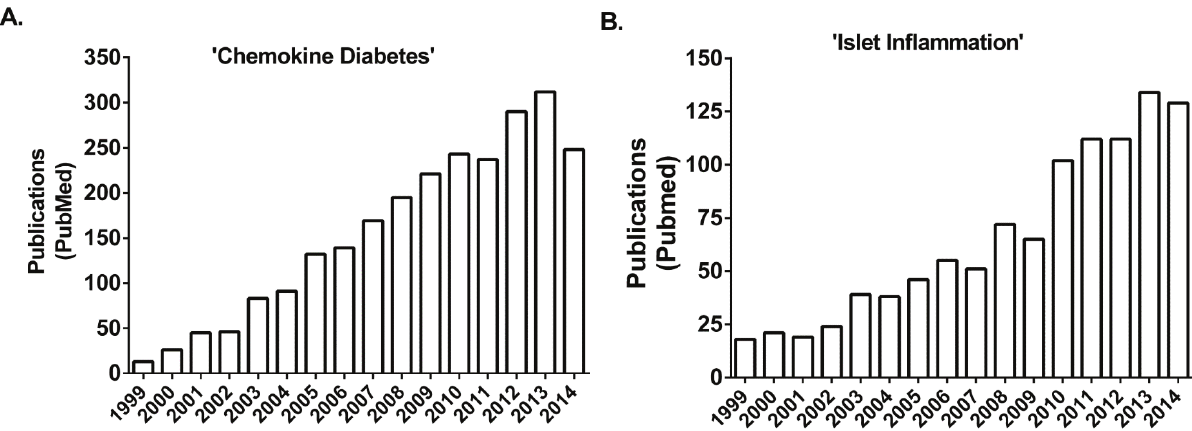
Figure 1. Rise in the number of publications involving chemokines, diabetes, and islet inflammation over a recent 15 year period. The number of publications (y-axis) identified using the search string shown in quotations above each graph ( A and B ) is shown by year (x-axis). Table 1. Chemokines elevated in pancreatic islets during pathophysiological states.